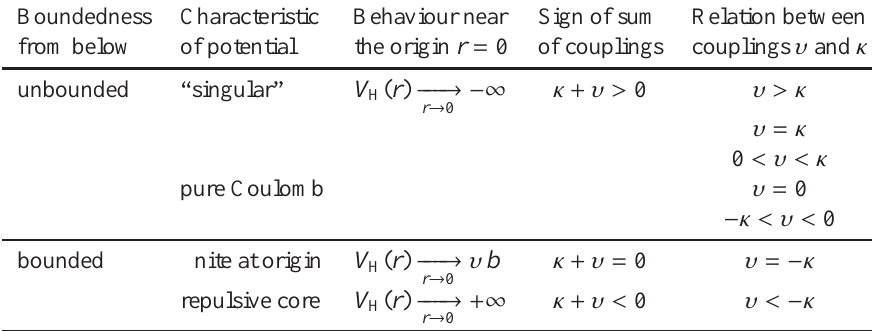
Table 1. Characterization of the seven types of generalized Hellmann potentials V H ( r ) distinguished by comparing the Yukawa coupling υ with the (by assumption nonnegative) Coulomb coupling κ (cid:9) 0